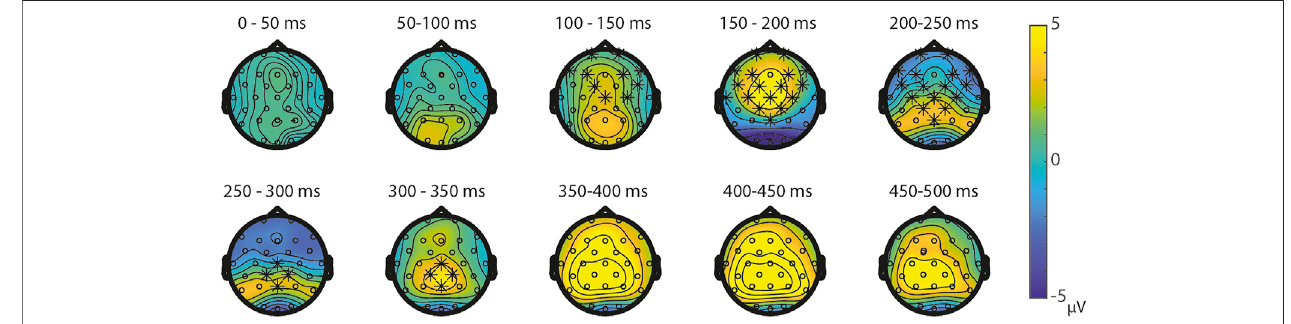
FIGURE 9 | Topoplots of the differences between the non-symbolic targets in the NsNs-task and the SNs-task with asterisks representing signi fi cant differences based on α (cid:1) 0.05.